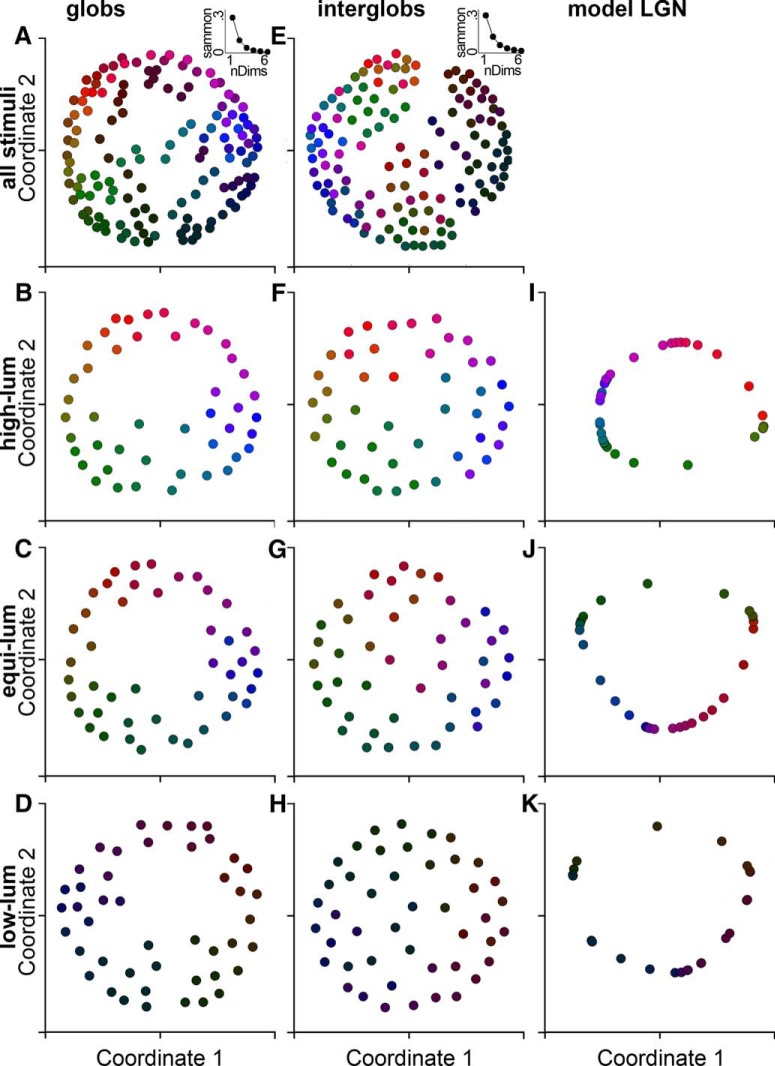
Glob, interglob, and LGN neural color spaces as calculated by MDS. Both the glob and interglob populations represent hue information, and these representations resemble the structure of perceptual CIELUV color space. A–K, MDS applied to the glob (A, B, C, D), interglob (E, F, G, H), and model LGN (I, J, K) responses to stimuli yields a picture of neural color space. Each stimulus has a high-dimensional neural representation, where each dimension corresponds to the mean firing rate of a single cell. MDS produces a low-dimensional embedding that seeks to preserve the distances between stimuli in the original, high-dimensional space. We use 1 − ρ (Pearson’s correlation coefficient) as our distance metric: stimuli are distant to the extent that the patterns of activity they evoke are uncorrelated. Stimuli are plotted by their color in coordinates determined by the new, two-dimensional embedding. A, B, Glob and interglob MDS embeddings of the full stimulus set (45 hues at three luminance each). Insets show Sammon’s stress as a function of embedding dimensions used. Glob (B–D), interglob (F–H), and model LGN (I–K) MDS embeddings of stimulus hues for each luminance level (Sammon’s stress for globs: low-luminance = 0.05; equiluminant = 0.06; high-luminance = 0.05; for interglobs: low-luminance = 0.12; equiluminant = 0.10; high-luminance = 0.10; for model LGN cells: low-luminance = 0.10; equiluminant = 0.10; high-luminance = 0.10).